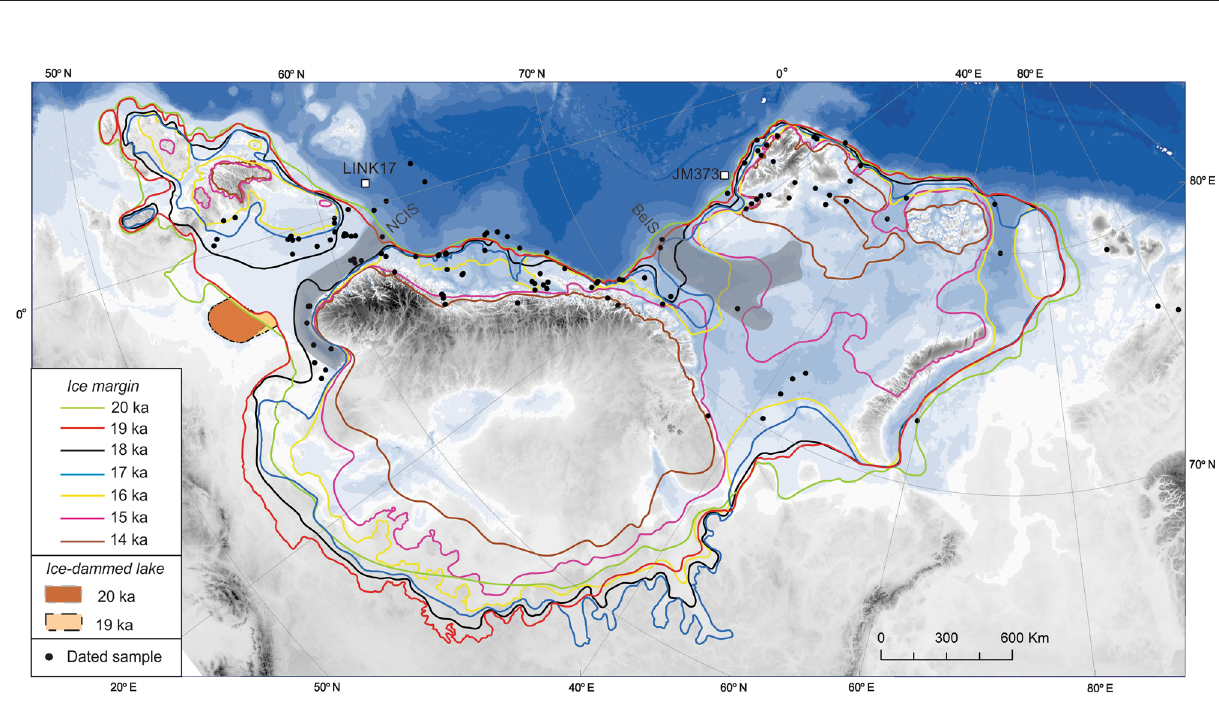
Fig. 1 Maps of investigated areas and mapped glacial landforms. a Overview map (bathymetry from www.gebco.net) with Last Glacial Maximum (20 ka) extent (black line) of the Eurasian Ice Sheet and boundaries (broken black lines) between the Kara-Barents Sea-Svalbard Ice Sheet (KBSIS), Fennoscandian Ice Sheet (FIS) and the British-Irish Ice Sheet (BIIS) indicated. Location of deep sea cores (LINK17 and JM373; white squares) and dated samples (Supplementary Note 1 and Supplementary Data 1 – 3) (black dots) are indicated. b , c Ice marginal features (red lines) and glacial lineations (black lines) mapped on the Mid Norwegian margin and compiled for the North Sea, largely based on refs. 9,10,12,22 . d Ice marginal features (red lines) and glacial lineations (black lines) in the Barents Sea-Svalbard region, compiled using datasets from refs. 32,61,62,67,82,83 . NC Norwegian Channel, FG Fladen Ground, DB Dogger Bank, SuT Suladjupet Trough, SkT Sklinnadjupet Trough, TT Trænadjupet Trough, BiT Bjørnøya Trough, ST Storfjorden Trough, StAT St Anna Trough, SI Shetland Islands, EA East Anglia.